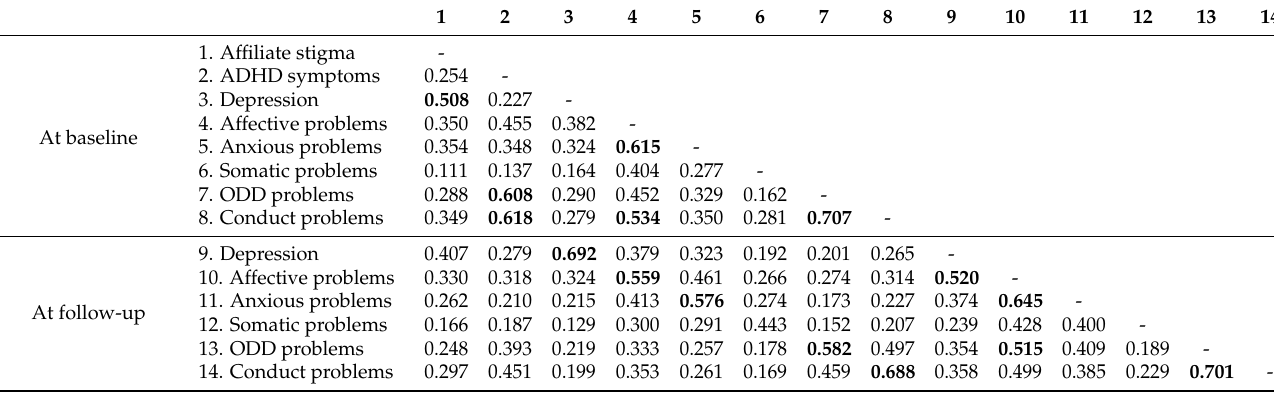
Table 2. Correlations among affiliate stigma and attention deficit hyperactivity disorder symptoms at baseline, caregivers’ depression, and children’s internalizing and externalizing symptoms at baseline and at follow-up: Pearson’s